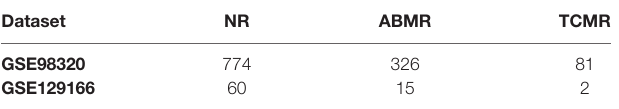
TABLE 1 | Overview of datasets composition.